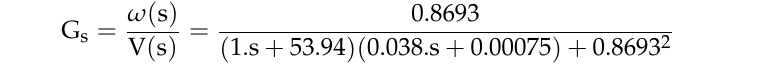
Figure 11. ( a , b ) Task and path planning of the mobile robot .